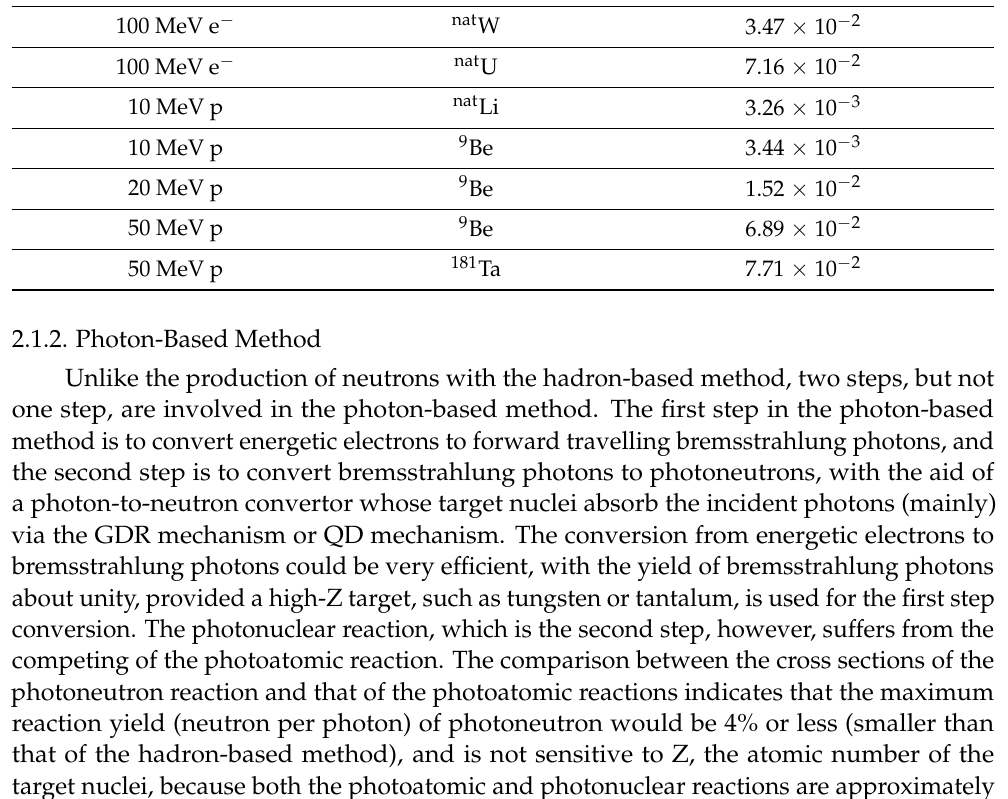
Table 1. Reaction yields of different targets for incident electron and proton of various energies. Incident Particle Target